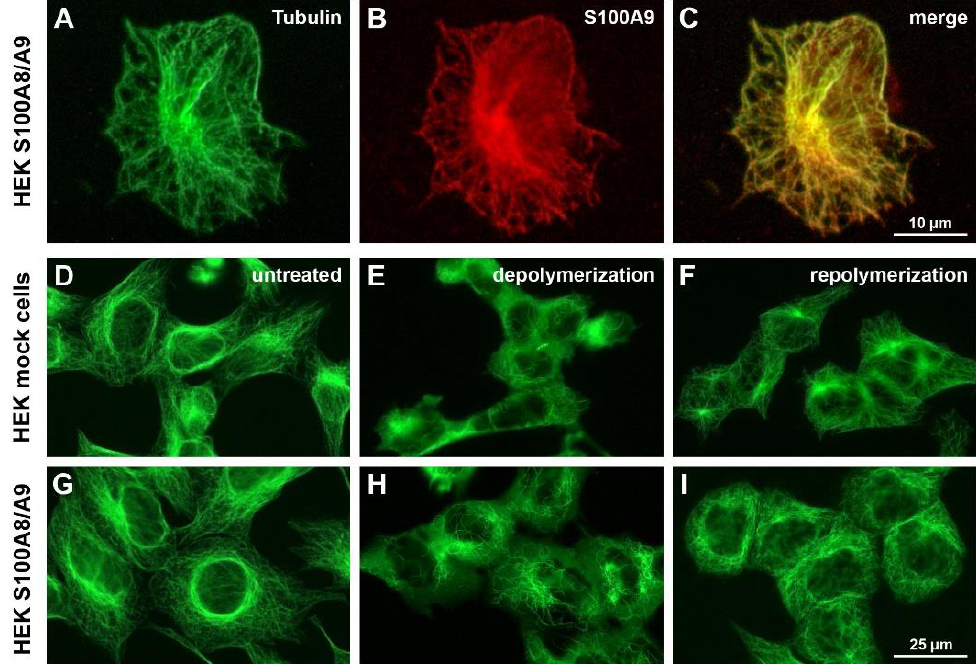
Figure 1. S100A8/S100A9 co-localized with MTs in S100A8/S100A9-transfected HEK293 cells. Double labeling immunofluorescence studies using anti-tubulin ( A ) and anti-S100A9 ( B ) antibodies showed clear co-localization ( C ) of S100A9 with MTs in PMA-stimulated (4 h/10 nM) cells after CS-T/CS fixation. Additionally, S100A8/S100A9 stabilized MTs and promoted their repolymerization ( D – I ). S100A8/S100A9-transfected HEK293 cells ( H ) showed more intact MTs after nocodazole treatment for 10 min in comparison to the mock-transfected control cells ( E ) as well as increased MT repolymerization 15 min after nocodazole washout ( I ). While the mock-transfected control cells ( F ) exhibited a MT cytoskeleton after repolymerization similar to that of the untreated cells ( D ), the transgenic cells ( I ) were characterized by a transient high amount of densely packed MTs compared to the corresponding untreated cells ( G ). Three independent experiments were performed and 25 cells per experiment were analyzed for each individual condition.